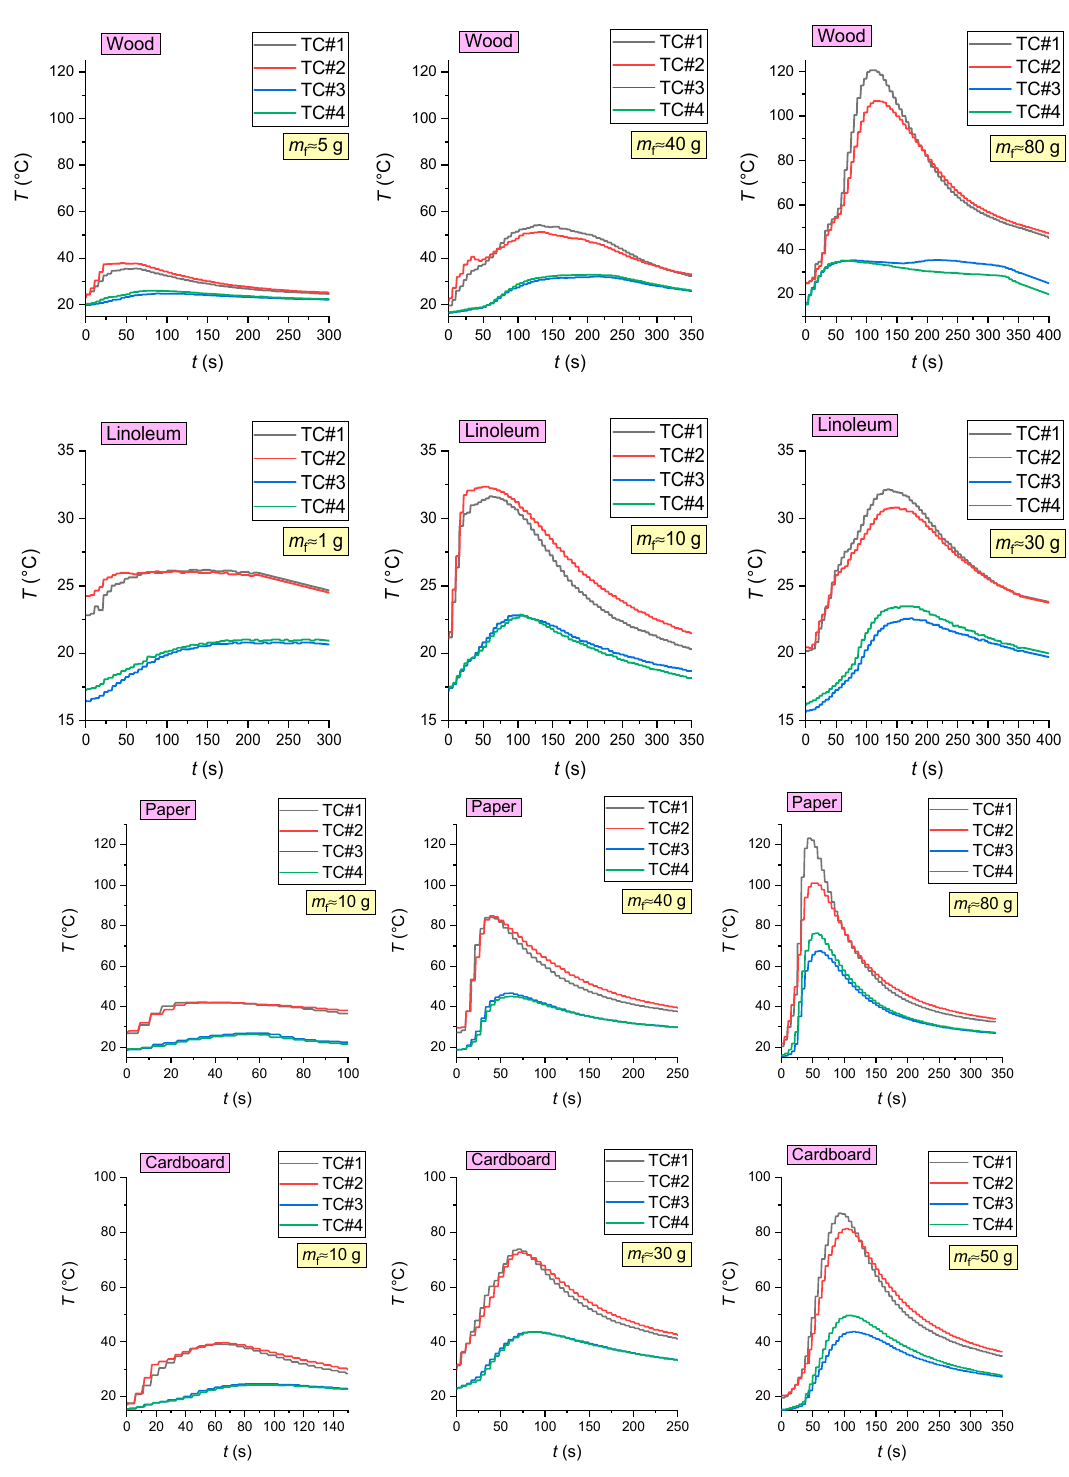
Figure 5. The thermocouple temperature trends (temperature versus time) in different areas of the SC during the combustion of materials (wood; linoleum; paper; cardboard).